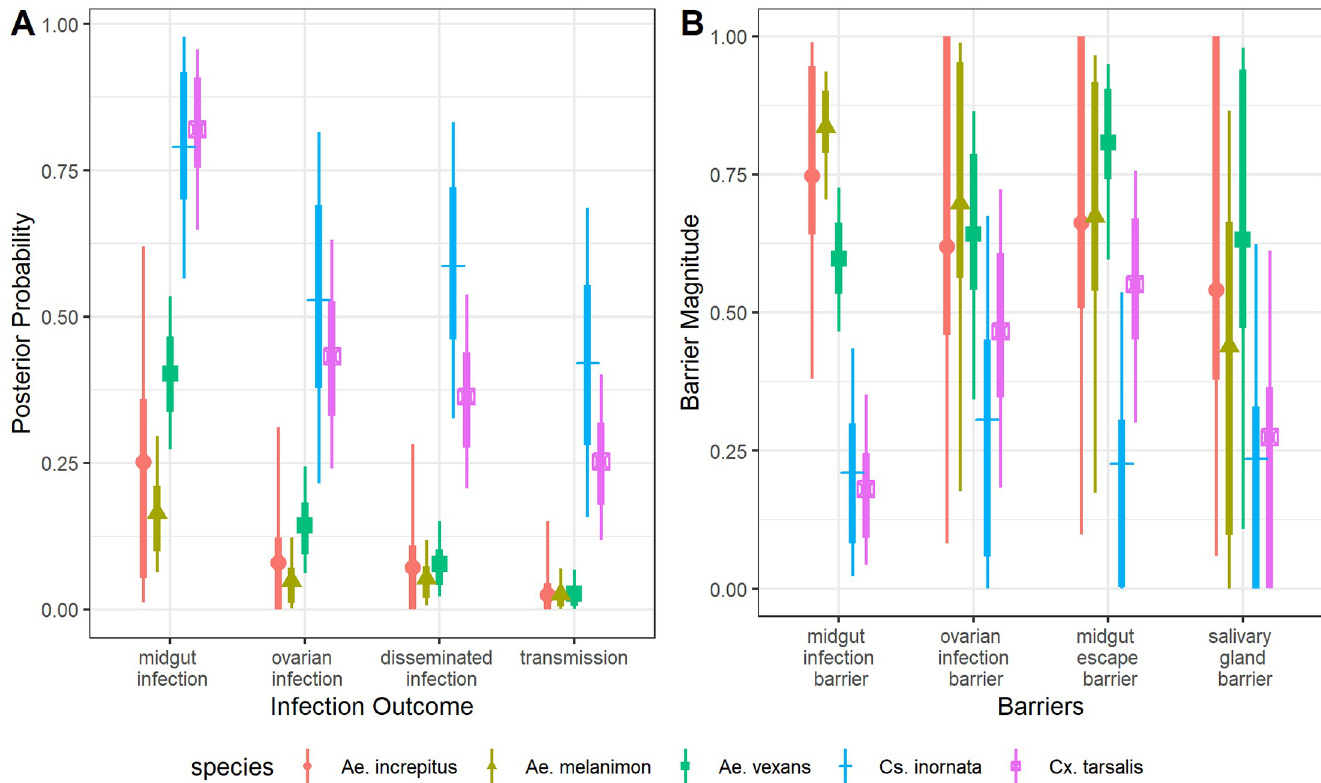
Fig 3. A shows the probability of each infection outcome. B shows the barriers to infection as independent, step-wise parameters. Points represent median posterior values, while the thin lines represent 95% credible intervals and thick lines represent 66% credible intervals. See also S1 Appendix and Table 1 for the definitions and associated model